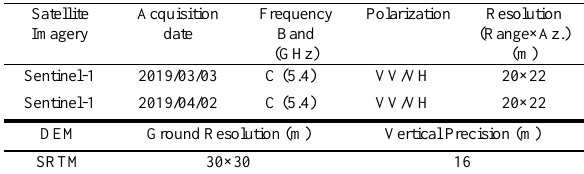
Table 1. Used data